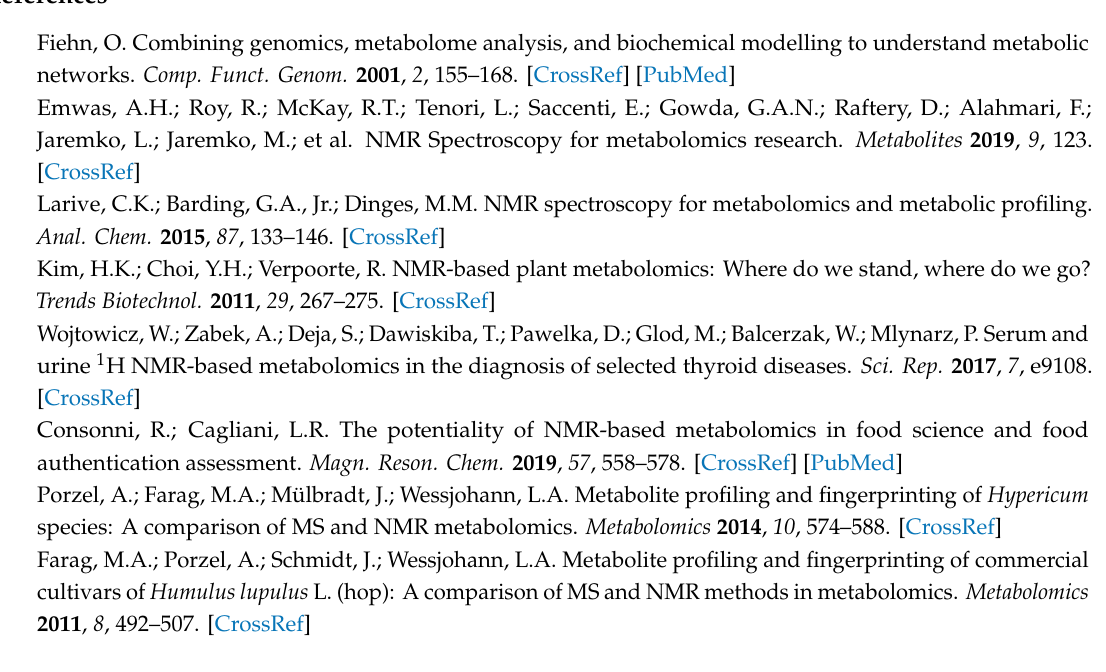
H-NMR data. Table S.1: List of plant material. Figure S.2: Graphical representation of di ff erent bin sizes for selected quantified signals. Table S.2: Quantitative correlation of bins of di ff erent signals. Figure S.3: Boxplot of correlation coe ffi cient for di ff erent experiments with di ff erent bin sizes. Figure S.4: Stacked conventional 1 H-NMR spectra of Hypericum species. Figure S.5: Stacked PSYCHE spectra of Hypericum species. Figure S.6: PCA scores plots of di ff erent